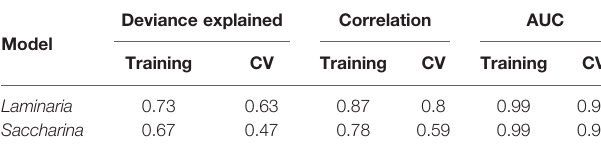
Devianceexplainedisthepercentageofdevianceforthenullmodel(nopatterninthedata) explained by the fi tted model (1 for a perfect model). Correlations are calculated between observational data and model predictions. The area under the curve (AUC) ranges between 0 and 1, where 0.5 indicates that the model classi fi es presence/absence no better than random, and 1 indicates perfect prediction. All metrices are calculated both fromtrainingdata(datausedformodel fi tting)andfromcrossvalidation(CV)(dataomitted from the model fi tting, i.e., 30 or 40% of the data at each iteration for Laminaria and Saccharina,